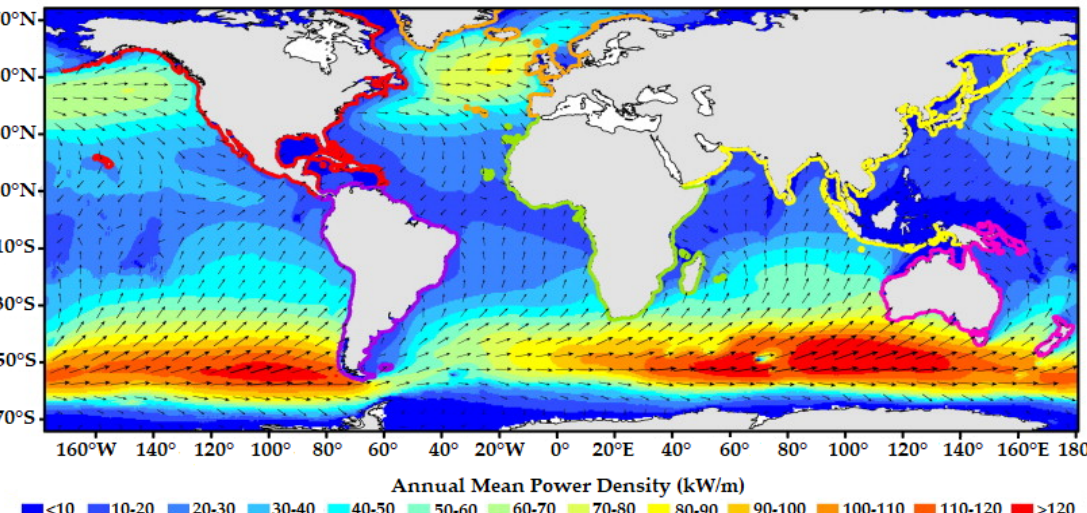
Figure 5. Global wave power GIS map (Reproduced with permission 5139241219046 from [25], Elsevier, 2012).